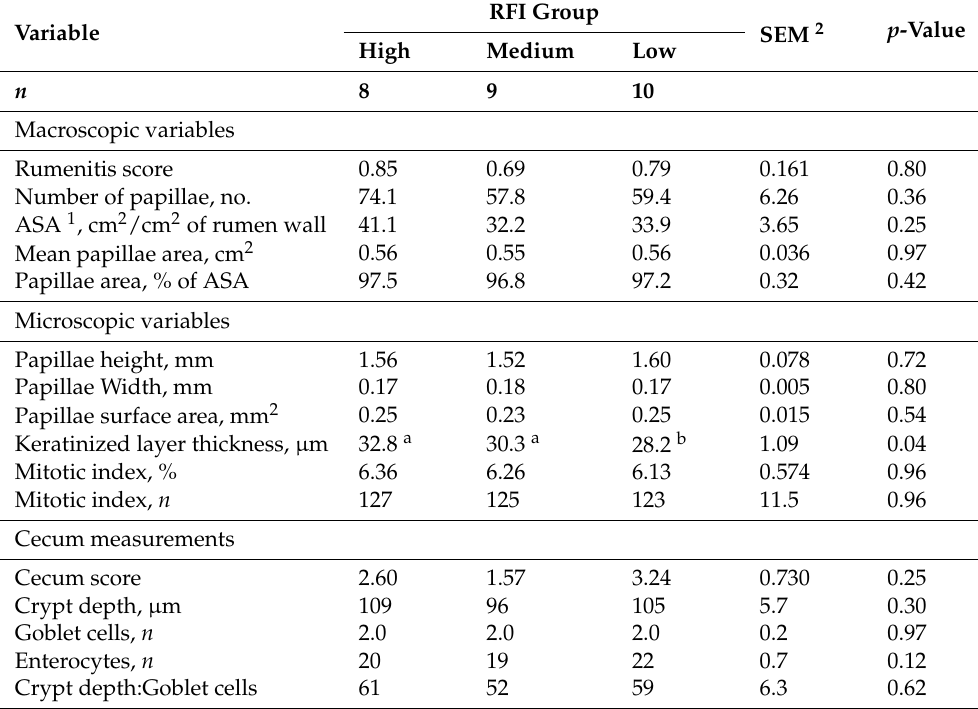
Table 4. Rumenitis and rumen morphometrics of rumen and cecum of Nellore yearling bulls con- suming high-concentrate diets classified by residual feed intake (RFI).